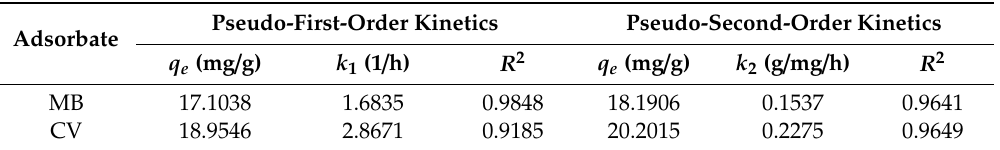
Table 1. Pseudo-first-order and pseudo-second-order model parameters for methylene blue (MB)